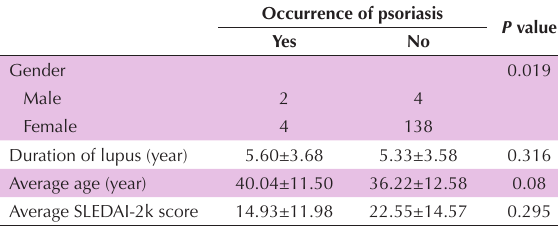
Table 1. The association of active lupus with psoriasis in patients studied Occurrence of